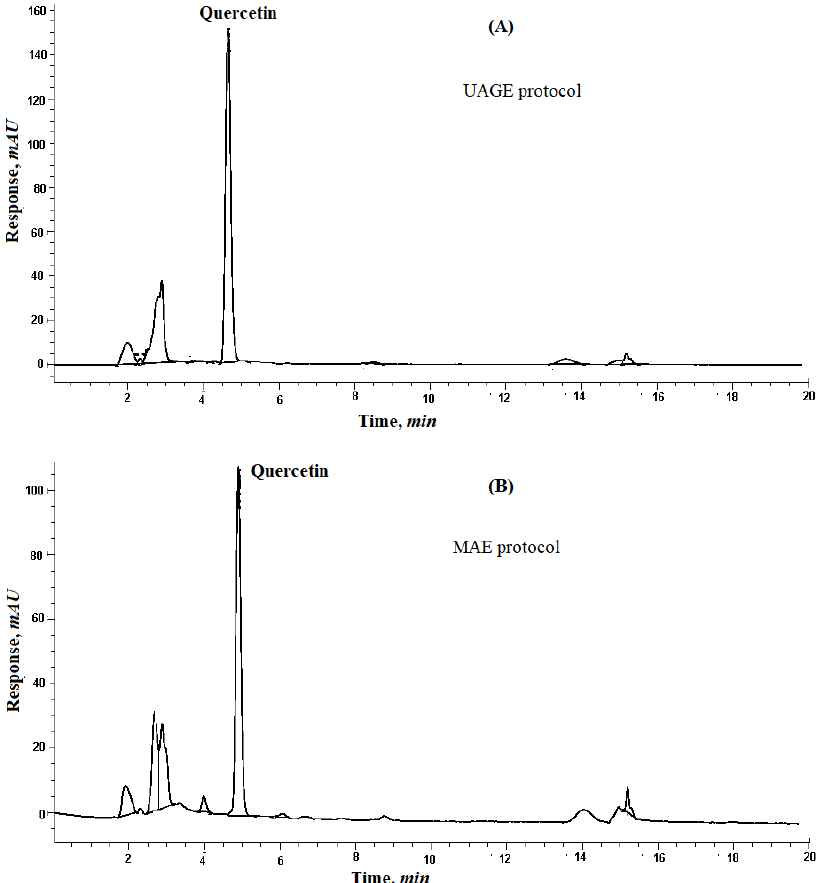
Figure 2. Graphs showing: HPLC chromatograms of quercetin from red onion scales after: ( A ) Ultrasound-assisted glycerol extraction and ( B ) microwave aided extraction protocols.